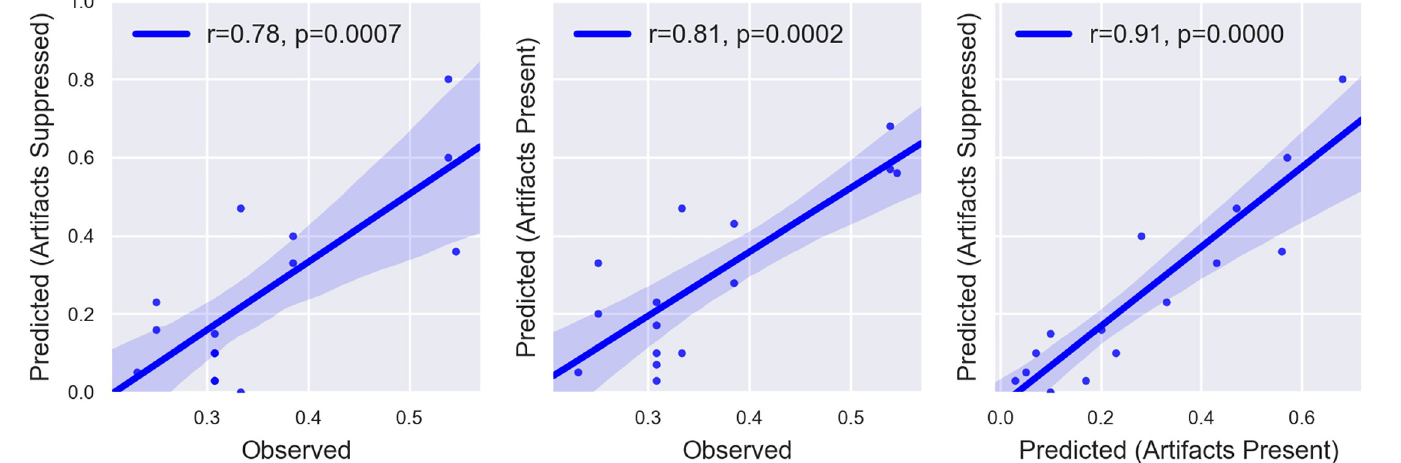
Fig 8. The relationships between observed and predicted MW